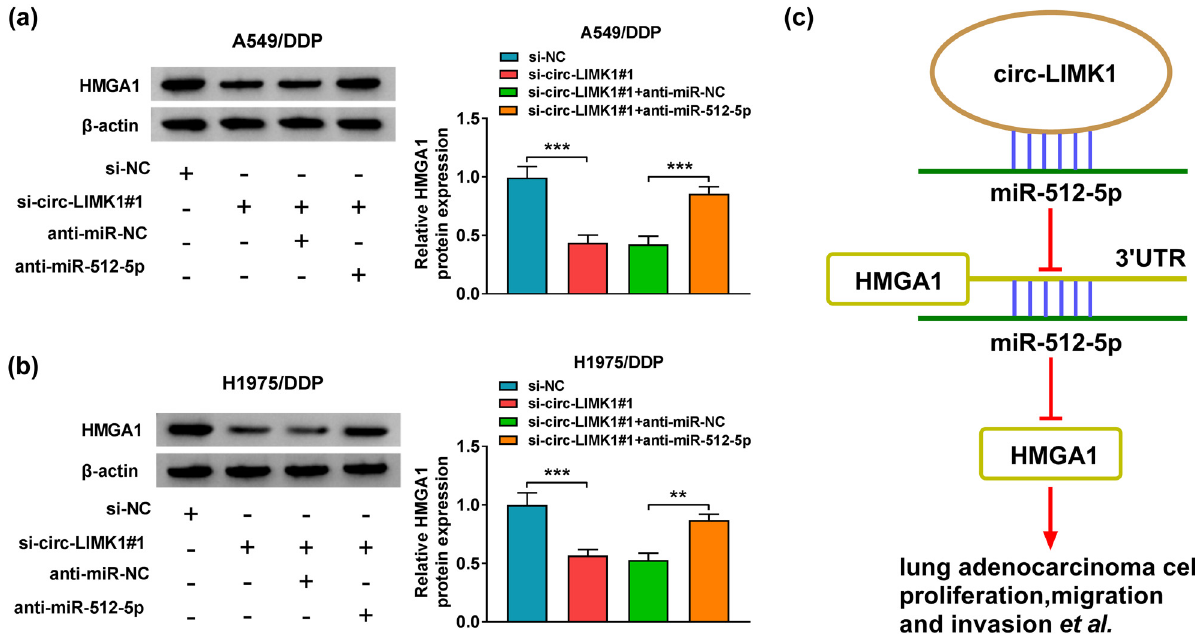
Figure 7: Anti - miR - 512 - 5p could restore the e ff ect of si - circ - LIMK1 in the related progression of lung adenocarcinoma DDP - resistant cells. ( a and b ) Western blot was used to detect the protein level of HMGA1 in A549/DDP and H1975/DDP cells after transfected with si - NC, si - circ - LIMK1#1, si - circ - LIMK1#1 + anti - miR - NC, or si - circ - LIMK1#1 + miR - 512 - 5p. ( c ) Functional mechanism diagram of circ - LIMK1, miR - 512 - 5p, and HMGA1. *P < 0.05, ** P < 0.01, *** P <